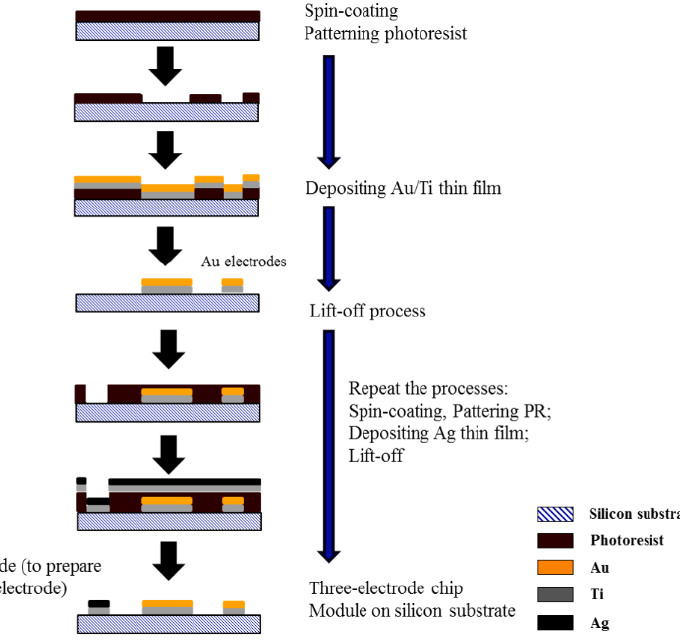
Figure 2. Three-electrode chip molding process flow. Table 1. Deposition conditions of metal layers (Ti, Au and Ag) on the substrate.